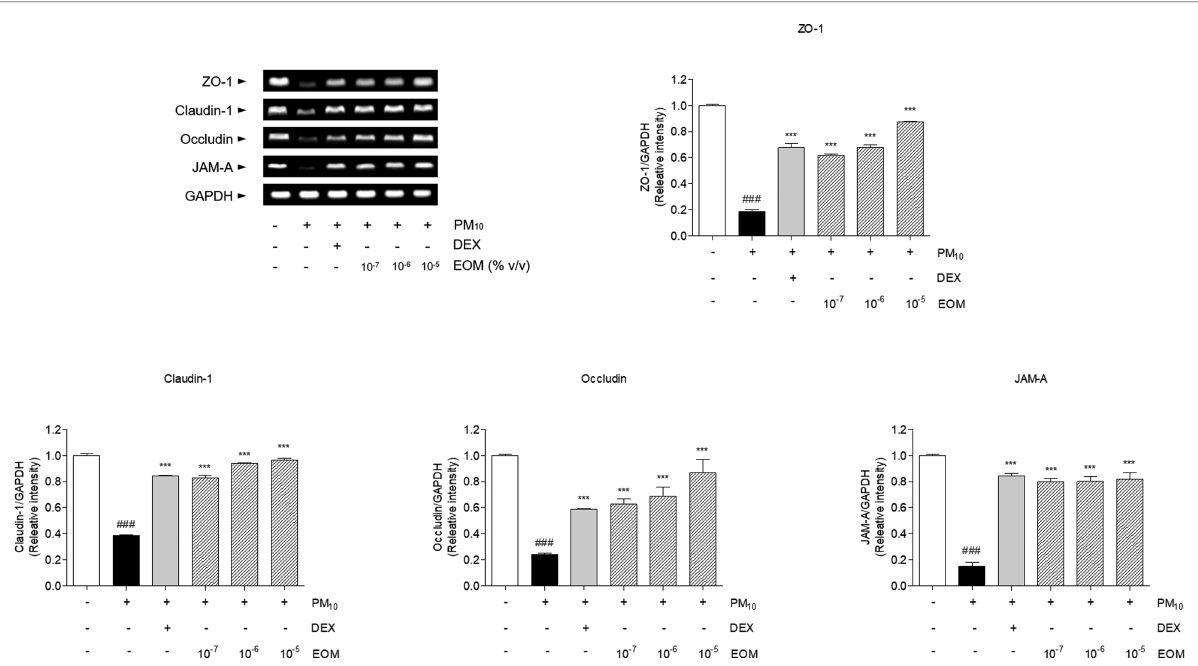
FIGURE 7 The expression of tight junction-related factors in PM10-treated RPMI2650 cells. The levels of tight junction related mRNA were visualized by RT- PCR analysis. Results are presented as mean±standard error of the mean. ### p <0.001 vs. CTR group * p <0.05, ** p <0.01 and *** p <0.001 vs. PM10-treated group. RT-PCR, reverse transcription polymerase chain